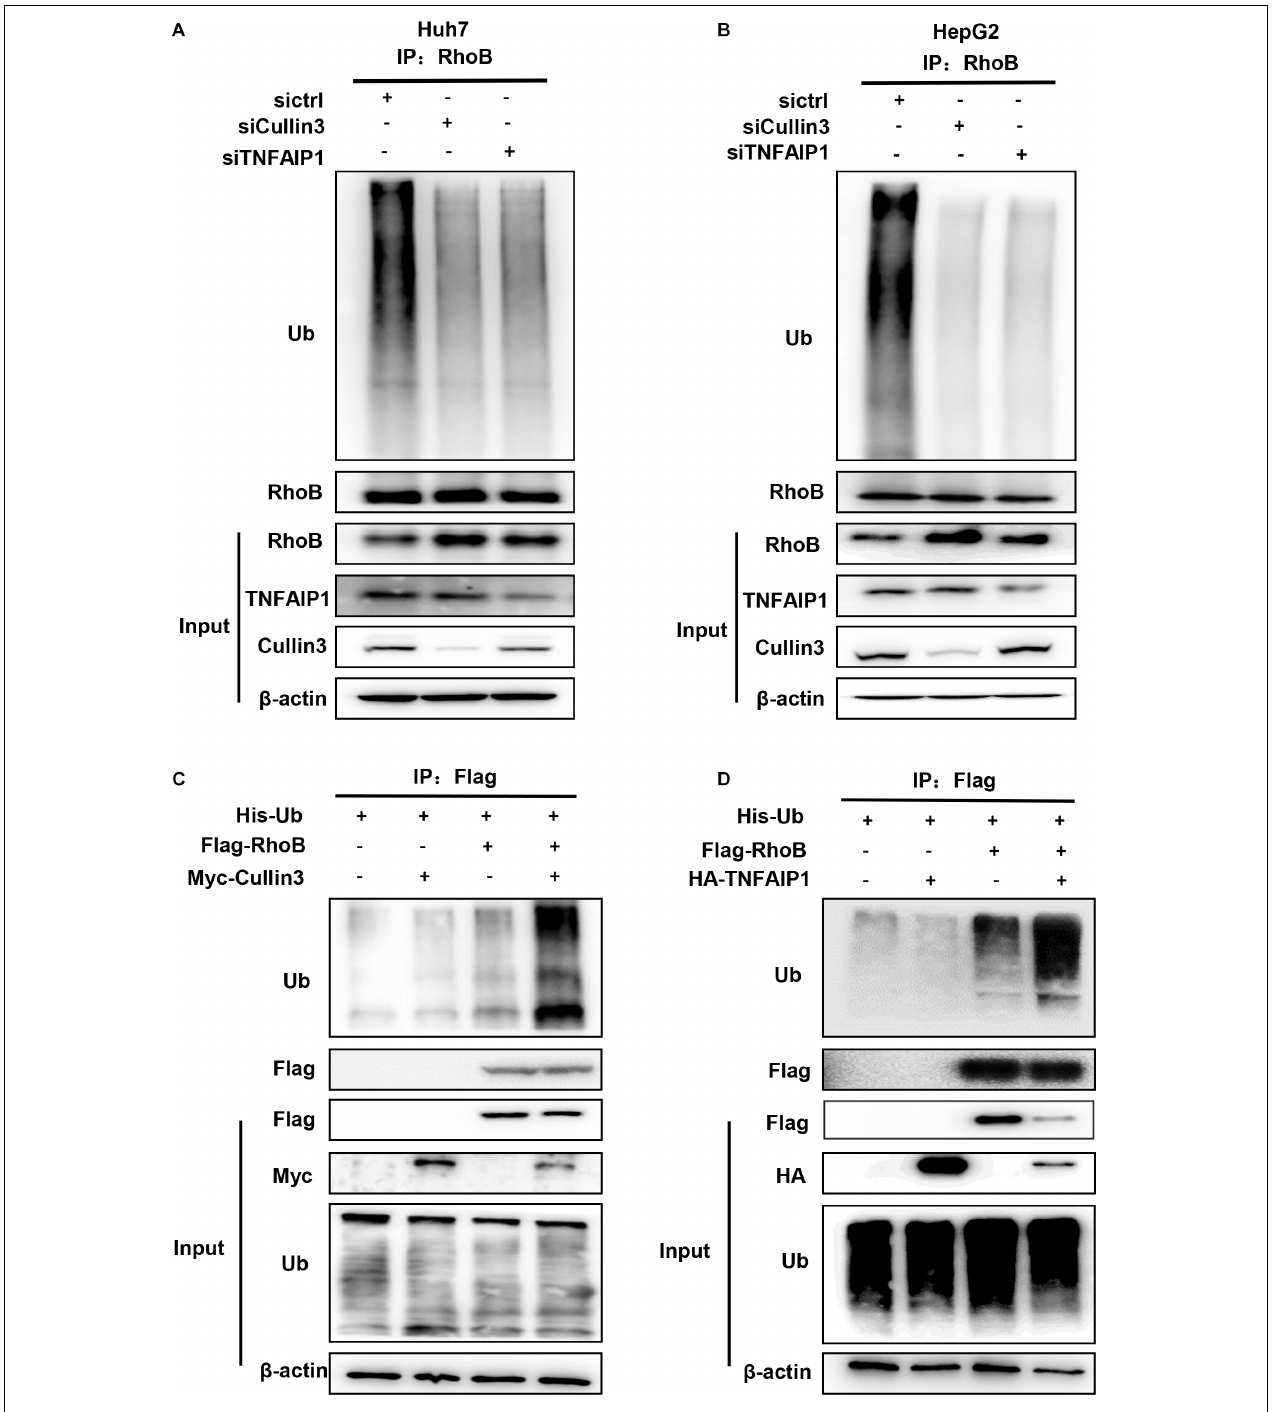
FIGURE 4 | Component of CRL3 mediated RhoB ubiquitination. (A) Downregulation of Cullin3 and TNFAIP1 inhibited RhoB polyubiquitination in Huh7 cells. Huh7 cells were transfected with ctrl (control), Cullin3 or TNFAIP1 siRNA for 96 h and followed with MG132 (5 µ M) for 6 h. Cell lysates were subjected to immunoprecipitation with anti-RhoB antibody. (B) Cullin3 and TNFAIP1 depletion suppressed ubiquitination of RhoB in HepG2 cells. HepG2 cells were transfected with ctrl (control), Cullin3 or TNFAIP1 siRNA for 96 h and followed with MG132 (5 µ M) treatment. Cell lysates were harvested and subjected to immunoprecipitation with anti-RhoB antibody. (C) Cullin3 promoted RhoB ubiquitination. HEK293T cells were transfected with indicated plasmids combinations of His-tagged Ub (His-Ub), Flag-tagged RhoB (Flag-RhoB), and Myc-tagged Cullin3 (Myc-Cullin3). Cell lysates were subjected to immunoprecipitation assay with anti-Flag beads. (D) TNFAIP1 promoted RhoB ubiquitination. HEK293T cells were transfected with indicated plasmids combinations of His-tagged Ub (His-Ub), Flag-tagged RhoB (Flag-RhoB), and HA-tagged TNFAIP1 (HA-TNFAIP1). Cell lysates were subjected to immunoprecipitation assay with anti-Flag beads.